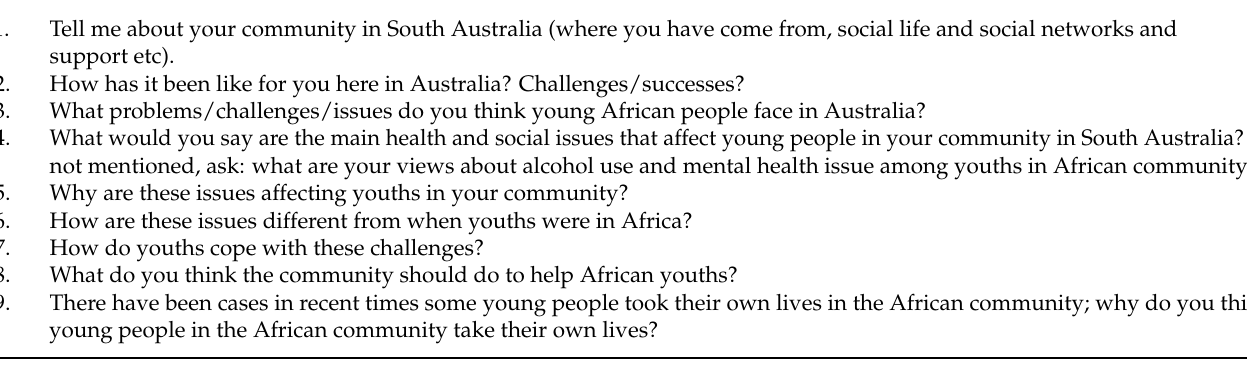
Table 1. Focus group discussion and interview